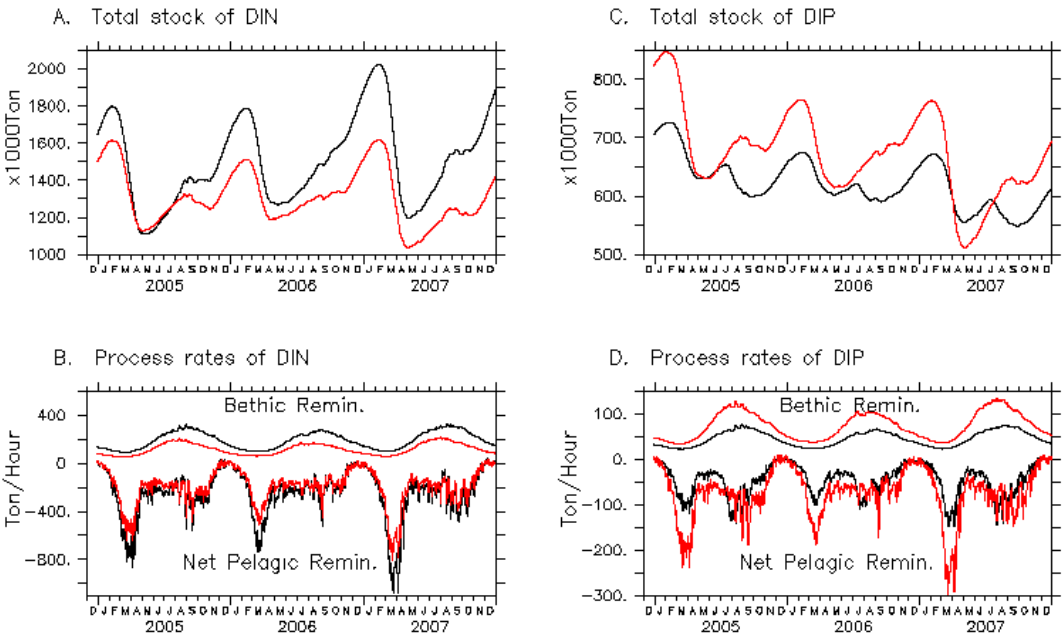
Fig. 4. Comparison between Case NP16 and Case NP6 for nutrient stocks and process rates for Case NP16 (black lines) and Case NP6 (red lines). Units: kiloton for stocks, ton per hour for process rates. DIN stands for dissolved inorganic nitrogen, DIP for dissolved inorganic phosphorus, “Net Pelagic Remin.” is the overall nutrient alteration rate caused by biological and biochemical processes in the water column (plotted as negative values), and “Benthic Remin.” is the overall nutrient alteration rate from benthic remineralization (plotted as positive